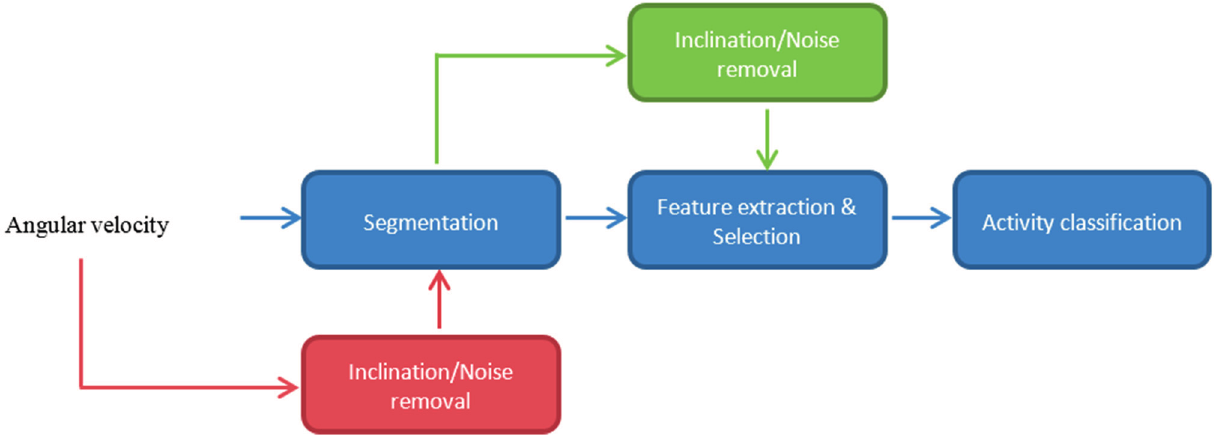
Figure 1. Workflow of the activity recognition